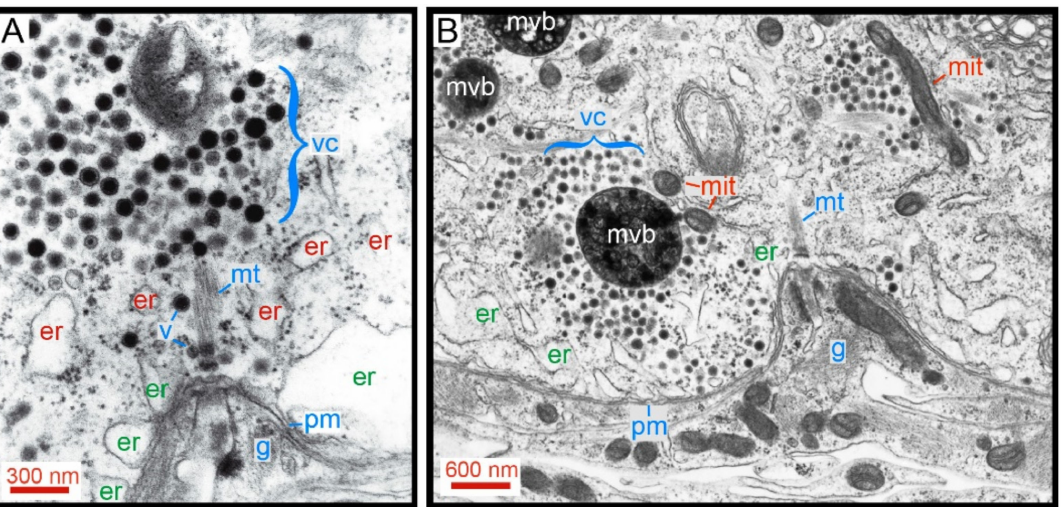
Figure 11. Cytoarchitecture of the vesicle transport pathway. ( A ) Amplified electron micrograph of a soma fixed after 1 Hz stimulation. A somatic vesicle cluster (vc) is bound to the plasma membrane (pm) though microtubules (mt). Peripheral endoplasmic reticulum (red er) rest apposed to the plasma membrane. A more internal layer of endoplasmic reticulum (green er) contains smaller bags. Individual vesicles (v) from peripheral clusters approach the plasma membrane along microtubules suggesting their contribution to constitutive exocytosis. Glial cell processes (g) penetrate an invagination of the Retzius neuron where microtubules anchor. ( B ) Electron micrograph of a release site in a neuron that had been stimulated with 20 Hz trains. Vesicles from a large cluster arrived at the plasma membrane after passing through a bottleneck of endoplasmic reticulum. Mitochondria (mit) travel around vesicle clusters. Multi-vesicular bodies (mvb) form upon endocytosis. Note that exocytosis occurs onto glia. Obtained with permission from